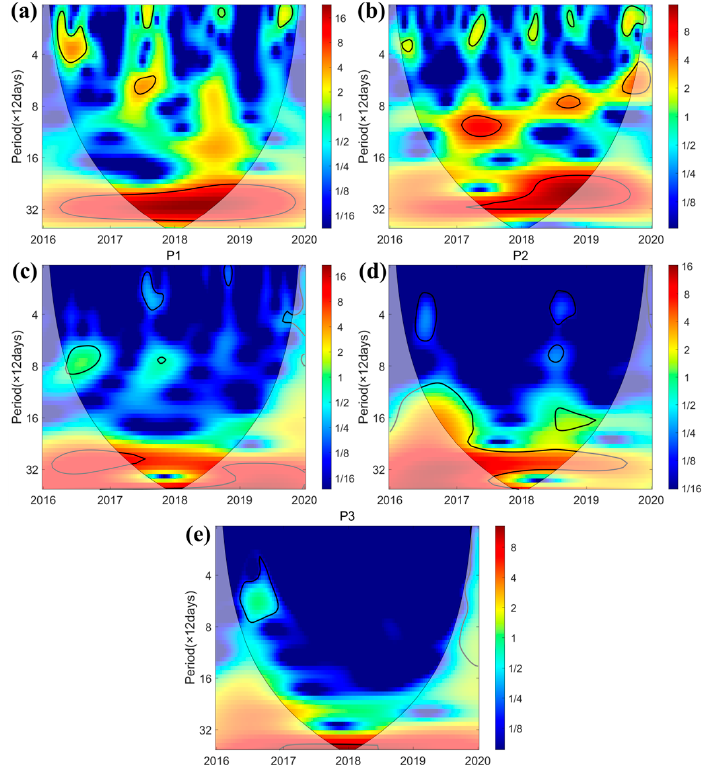
Figure 11. CWT results for different time series data: ( a ) rainfall, ( b ) reservoir water level, ( c ) nonlinear deformation component of P1, ( d ) nonlinear deformation component of P2, ( e ) nonlinear deformation component of P3. The colors in the figure represent the strength of the wavelet power spectrum, with red and blue indicating the peak and valley values of the energy, respectively. The thick black contours indicate the 5% significant level against red noise. The areas with half-transparent masks designate the cone of influence (COI), where the results are unreliable due to the non-negligible edge e ff ects. We use the same layout for Figures 11–13.